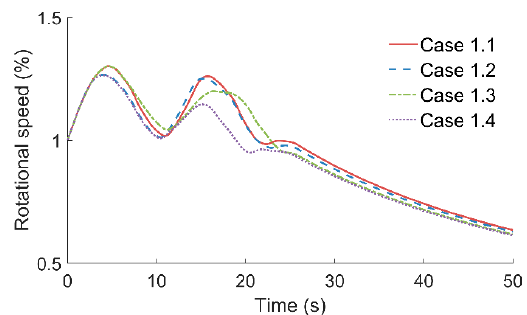
Figure 13. Comparison of rotational speeds between subcases in Case 1.